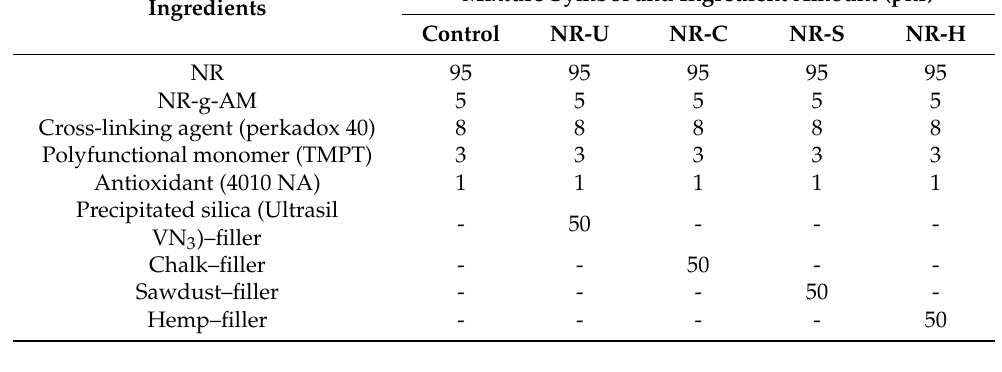
Scheme 1 shows the grafting mechanisms of maleic anhydride on the natural rubber chain and the obtaning of maleated natural rubber [30,31]. Possible cross-linking/grafting ways of cellulose from wood sawdust or hemp on the natural rubber chains are pre- sented in the Scheme 2a,b. The natural rubber and cellulose join together through the C-C and C-O-C bonds